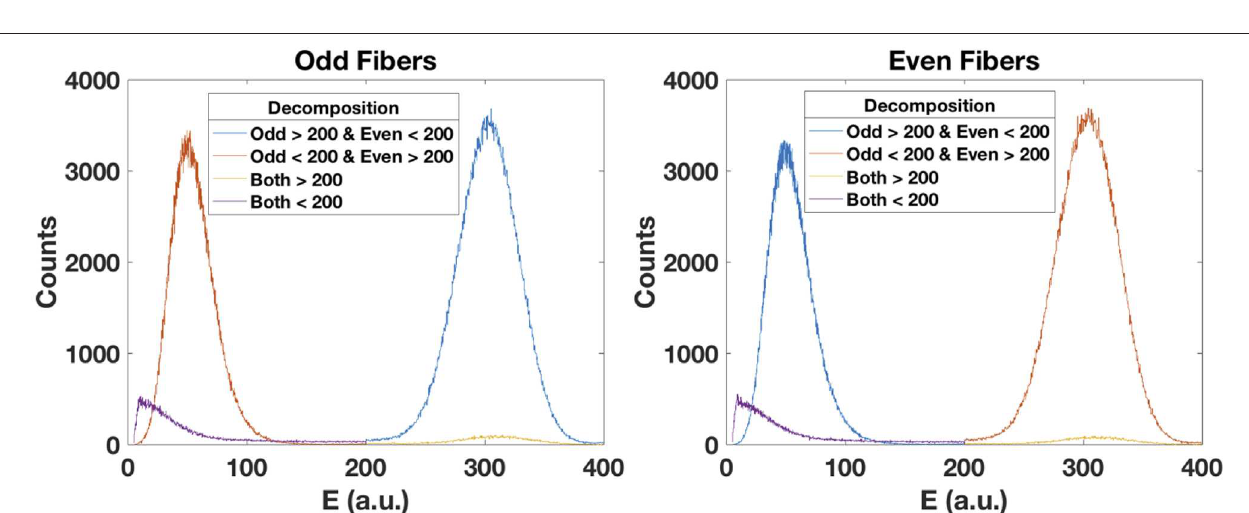
FIGURE 10 | Energy deposited by carbon (left) and helium (right) beams in the scintillating fibers and in the two plastic scintillators. An expected Gaussian shape for heavier particles is observed. The distributions from lighter particles resemble a Landau distribution as expected for a thin target.